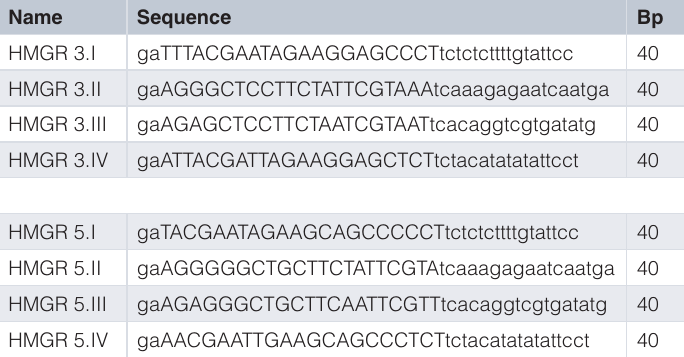
Table 4. Sequences for HMGR amiRNAs.